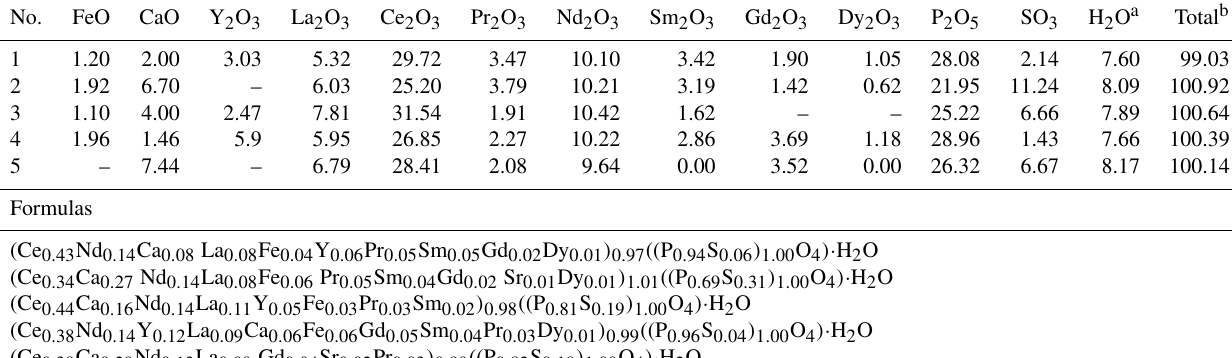
Table 3. Representative chemical composition (wt%) and crystal chemical formulas of rhabdophane. No.